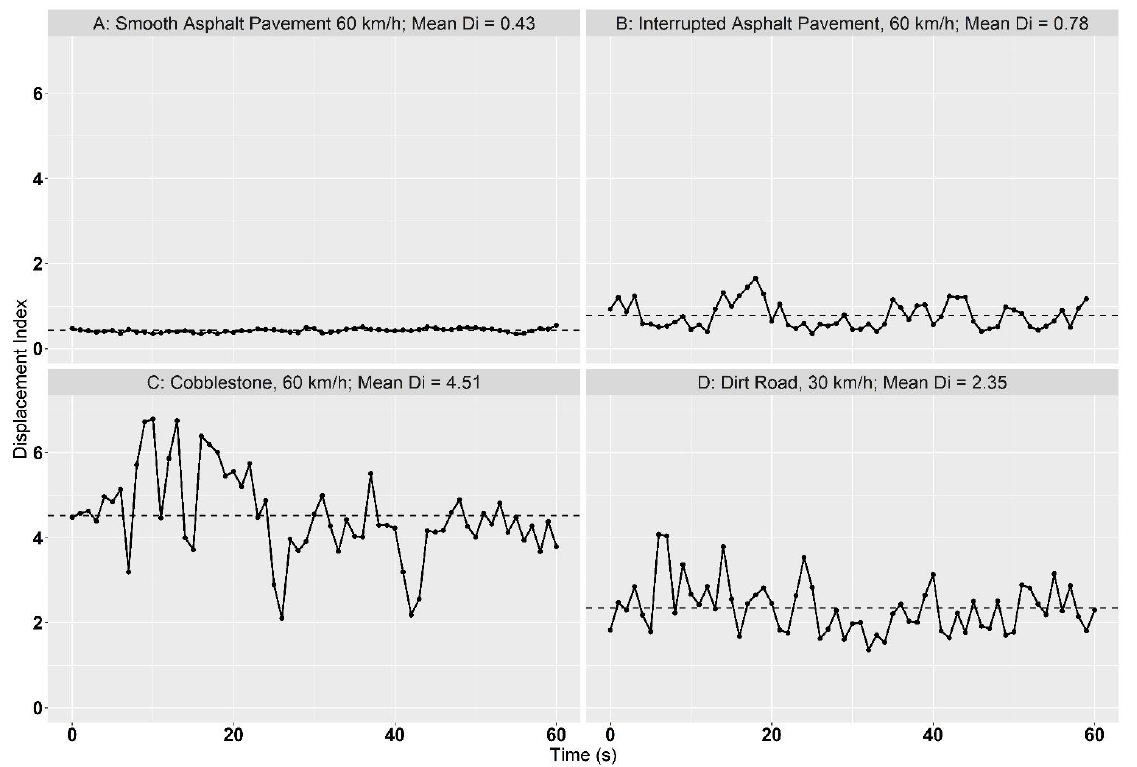
Figure 2. Exemplary Displacement Index curves for selected test runs. Dots on the chart line represent single measurement points of D i -values, and the dashed line shows the mean Displacement Index (D x ̅ ) of this test run. Table 2. Summary of vibration emissions during road trials ( n = 120, 10 in each category) depending on road surface and speed. Several different routes were selected for measurements and each trial lasted t = 60 s. The speed kept constant with a cruise control.